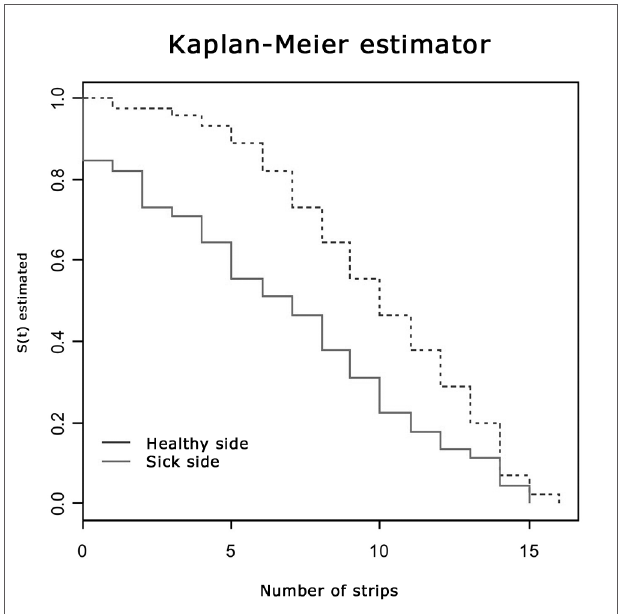
Figure 1. Survival Analysis Graph by the Kaplan-Meyer technique analyzing the results from the taste test for each side. Table 2. Tests confirming Fig. 1 findings in the survival analysis: